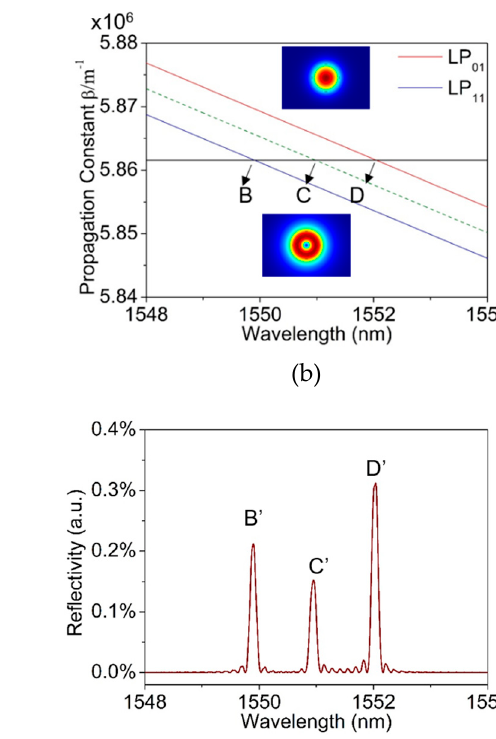
Figure 1. The relation between the transmission mode and diameter of the fiber the insets are mode fields of vector modes in two-mode fiber and the relationship of vector modes and LP modes.